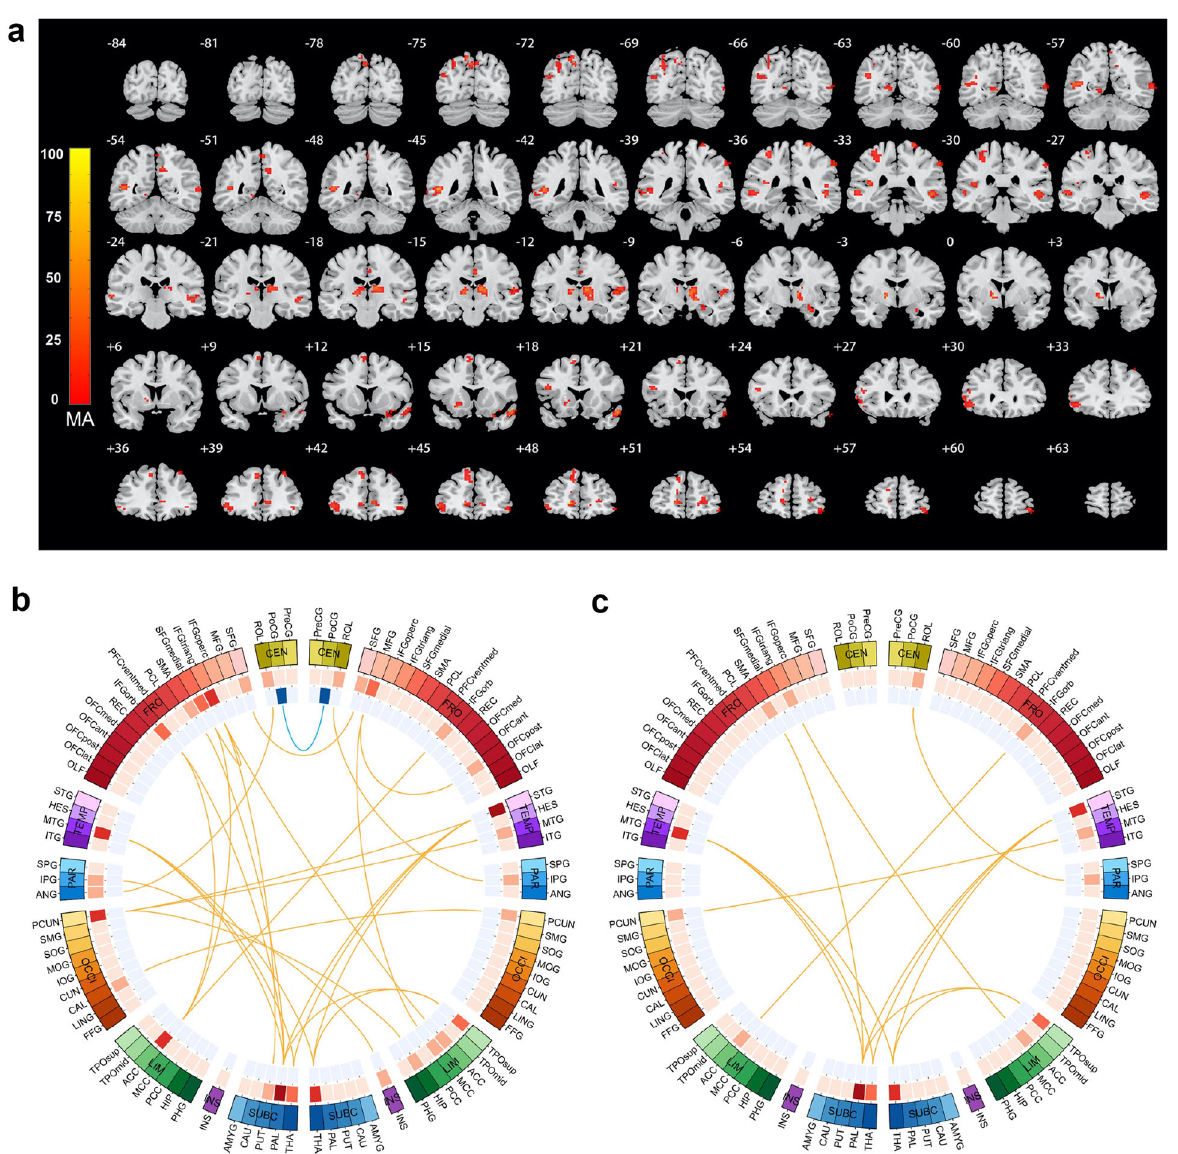
Fig. 1 Signi fi cantly altered functional connectivity clusters (FC clusters) identi fi ed in the fi rst-episode schizophrenia (FES) patients compared to healthy controls in the primary and validation dataset. a Voxels showing the largest number of voxel-level functional connectivity differences in FES patients in the primary dataset. The color bar represents the measure of association (MA) which is the number of signi fi cantly altered functional connectivities relating to each voxel. b Signi fi cantly altered FC clusters identi fi ed in FES patients in the primary dataset (33 FC clusters in total, details see Supplementary Table 2). The color of the 3 circles (from inside to outside) denotes: the number of deceased links; the number of increased links; the 94 different automatic anatomical labeling (AAL2) regions. Red lines mean that patients have a higher mean functional connectivity than controls, and blue lines indicate the opposite. The anatomical abbreviations in the fi gure are shown in the Supplementary Table 1. c 16 of the 33 signi fi cantly altered FC clusters were replicated in an independent validation dataset, involving the left inferior frontal triangular gyrus, bilateral thalamus, the left middle temporal lobe and the right superior temporal